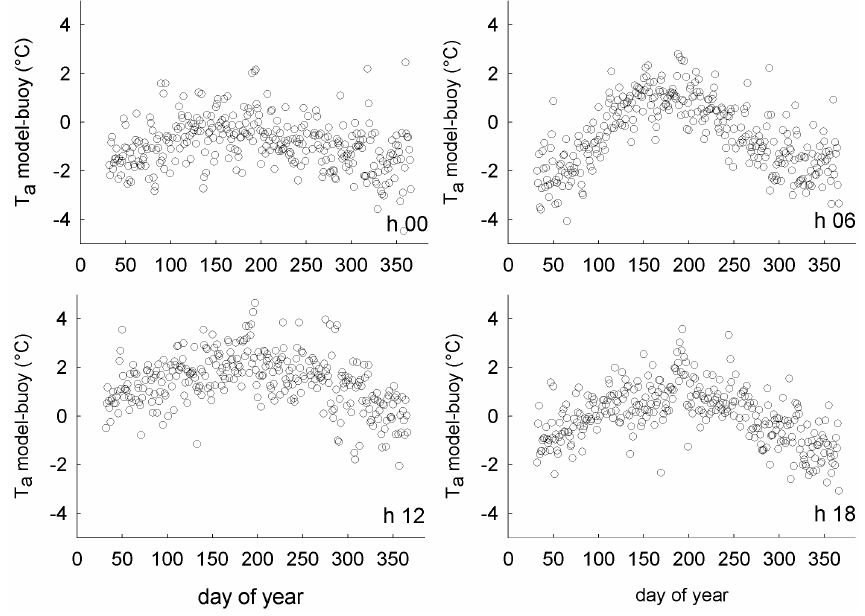
Fig. 7. Differences of hourly air temperature ( T a ) values between the model (basin average data) and the buoy as a function of the four synoptic